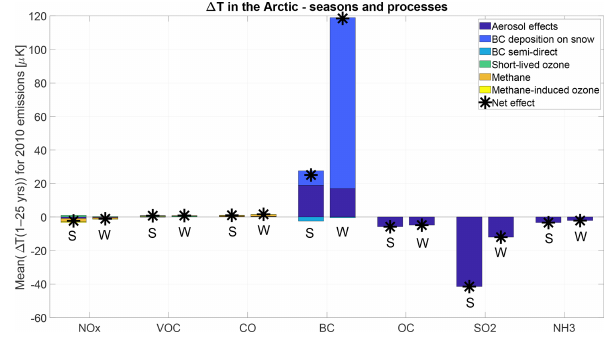
Figure 7. The temperature response (µK) in the Arctic of Finnish emissions in 2010, by applying the mean temperature 1–25 years after the pulse emission. This figure compares emissions occurring in summer (S) vs. winter (W) by applying ARTP values (Aamaas et al., 2017; Sand et al., 2016).